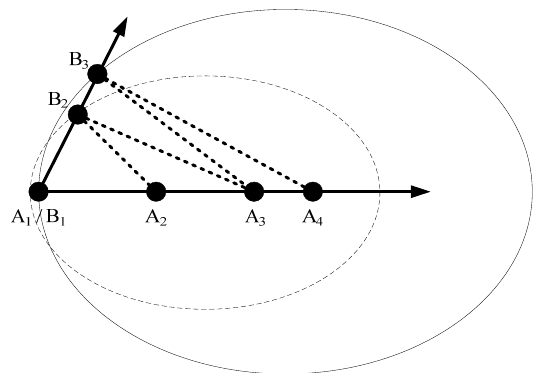
Figure 5. Novel definition of opposite path (Forward Ellipse).